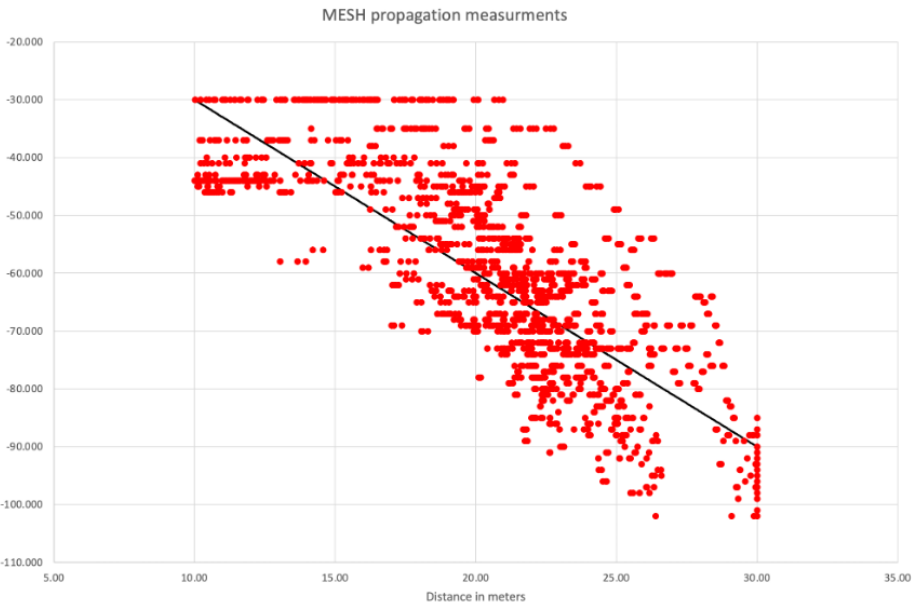
Figure 6. The log of the distance versus the log of the signal graph with a simple slope intercept model.